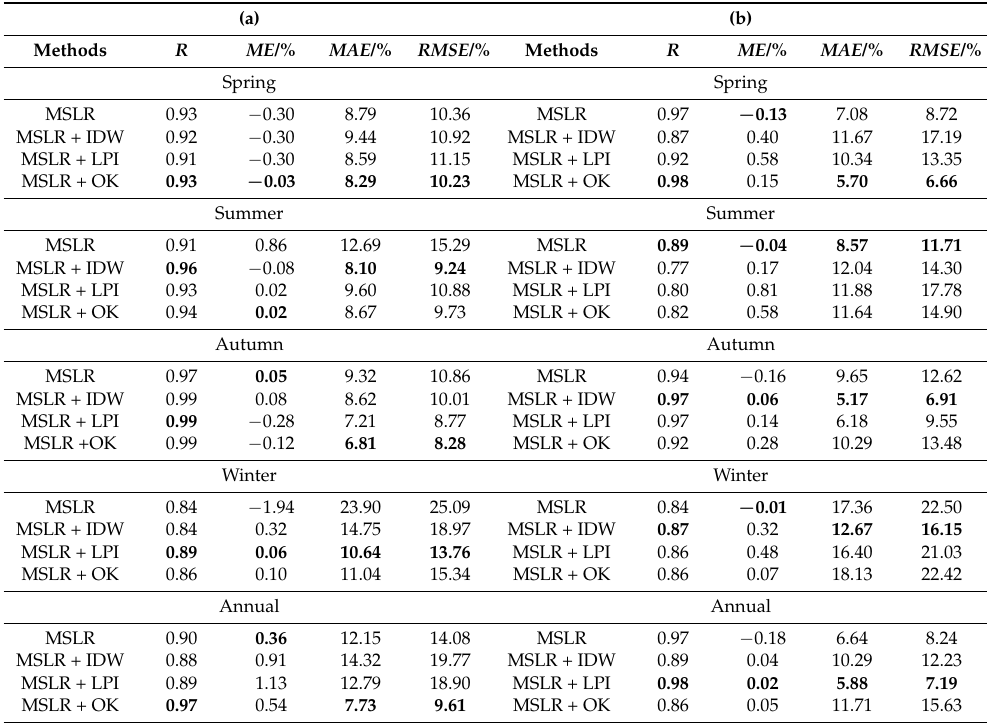
Table 7. Statistical comparison of the estimating effect of four methods ( a ) for estimating models (EM), ( b ) for estimating models with elevation below 1700 m EMB and estimating models with elevation above 1700 m